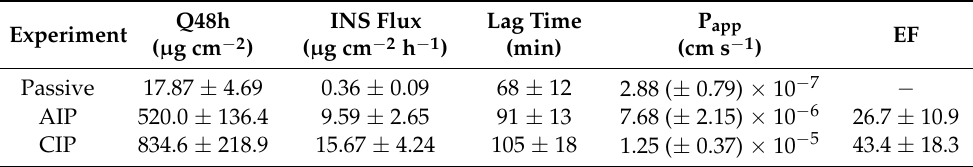
Table 1. Skin permeation parameters for INS after 48 h; Average Values ± SD, n = 3.